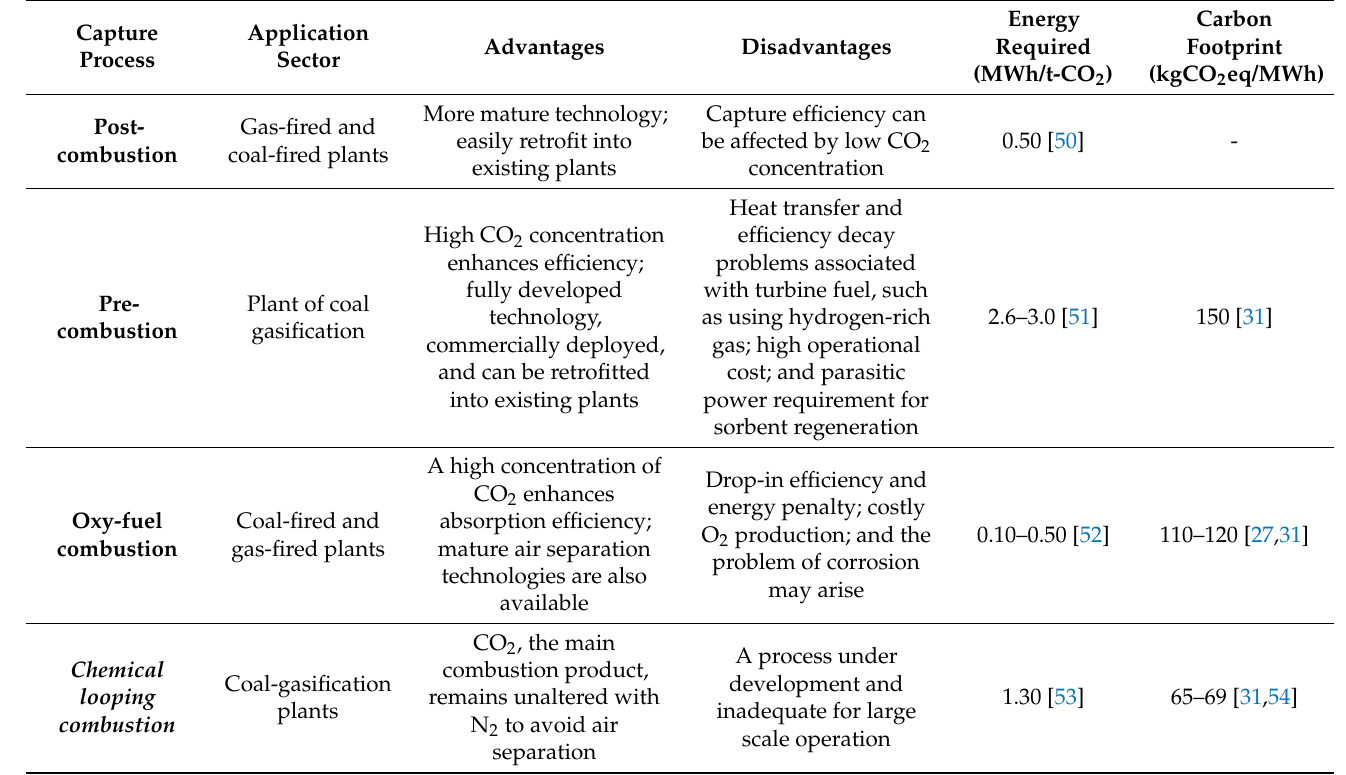
Table 2. Comparison of Four Capture Processes